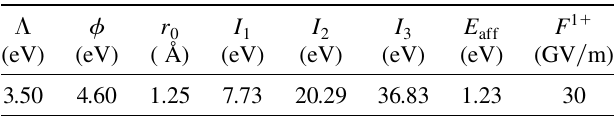
TABLE I. Parameters for copper tip and critical electric